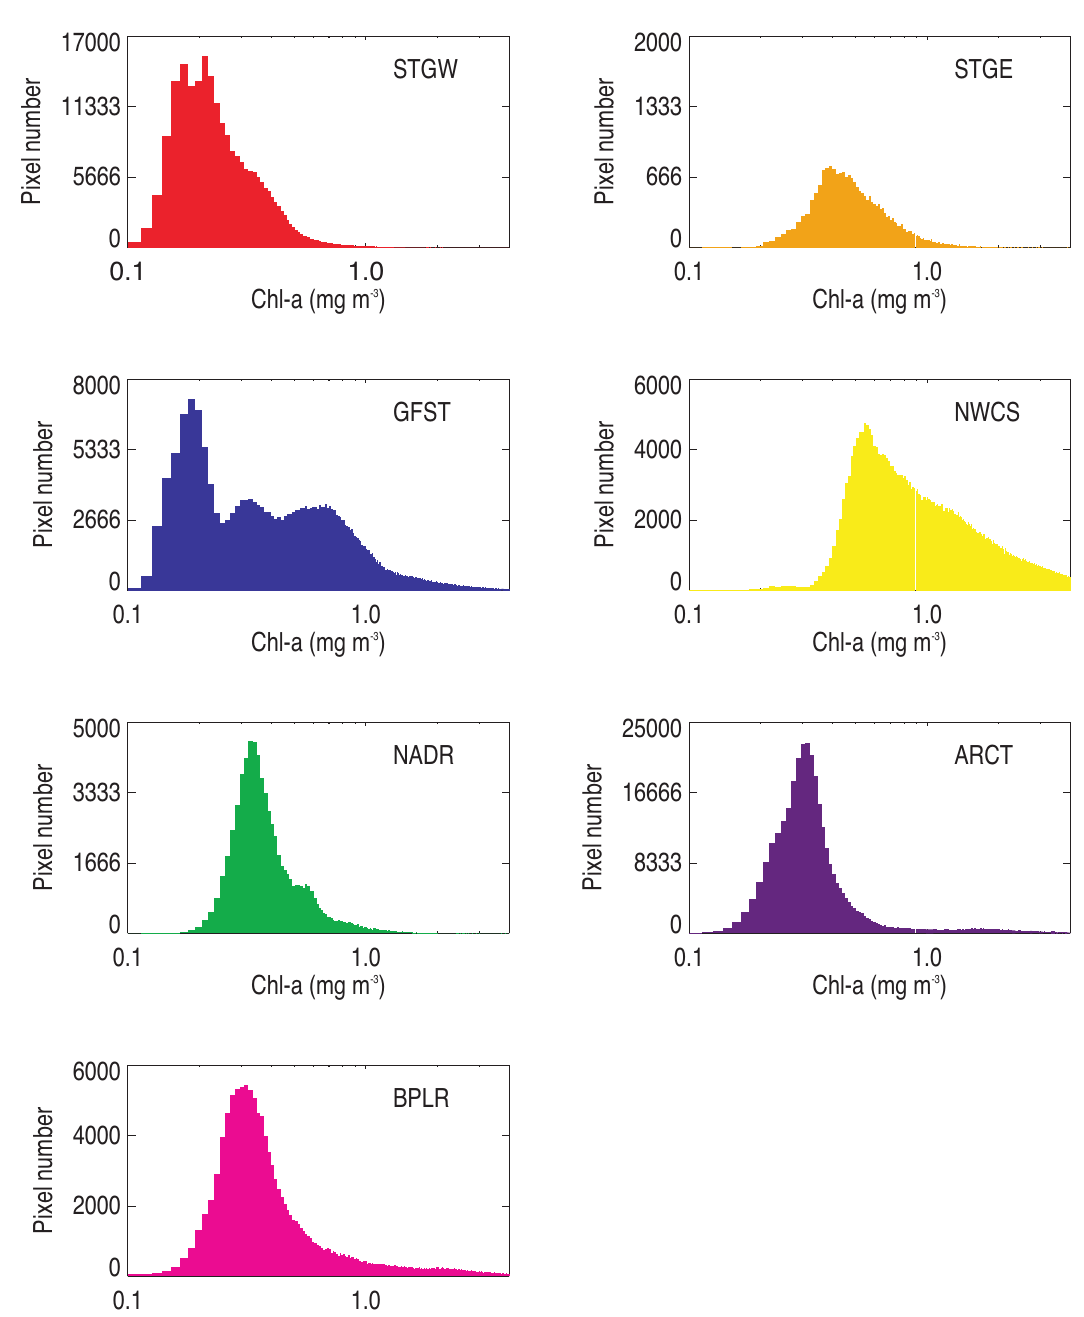
Fig. 8. – Frequency distribution of chlorophyll concentrations for the spring season extracted from the composite image for the provinces defined by Sathyendranath et al .